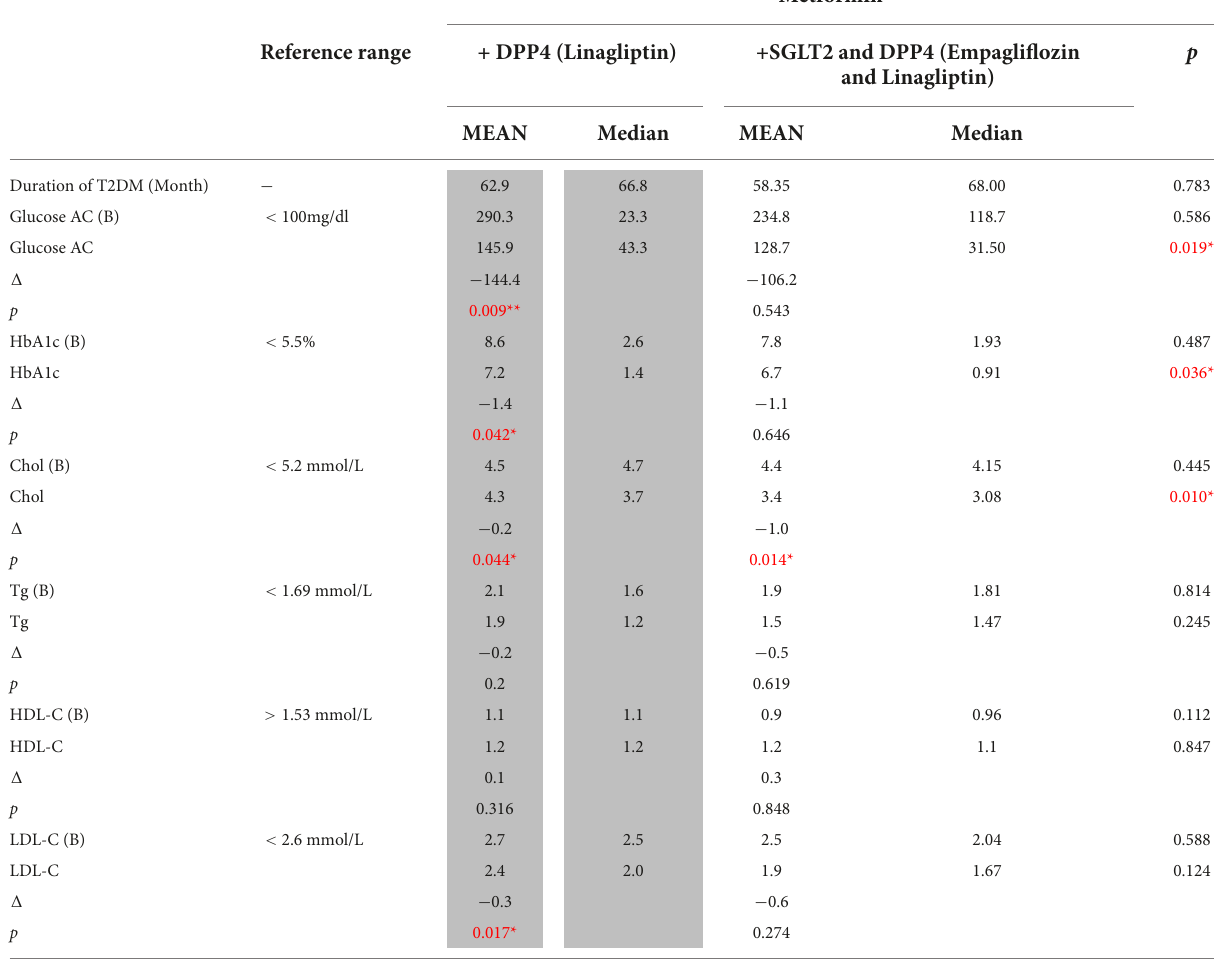
TABLE 3 Effects of metformin with linagliptin dual therapy and metformin with linagliptin and empagliflozin triple therapy on lipid profile and blood glucose control of patients with type 2 diabetes